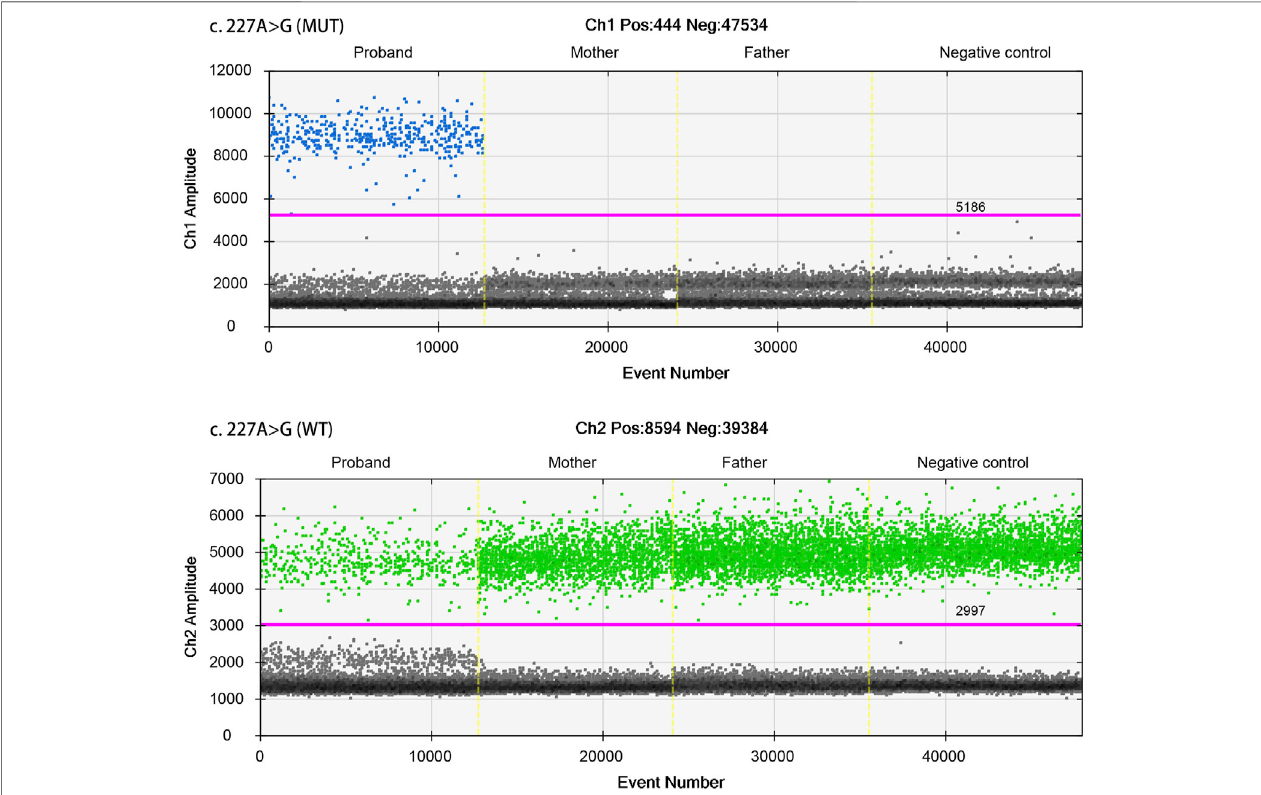
FIGURE4| DropletdigitalPCR(ddPCR)formosaicvariationdetection. ThefourddPCRsaredividedbyverticaldottedyellowlinesfortheproband,mother,father, and negative control. The pink line is the threshold, above which are positive droplets (blue and green), and below which are negative droplets (gray) without any target DNA. There is no target DNA for the mutant locus c.227A > G in the mother and father (top panel).